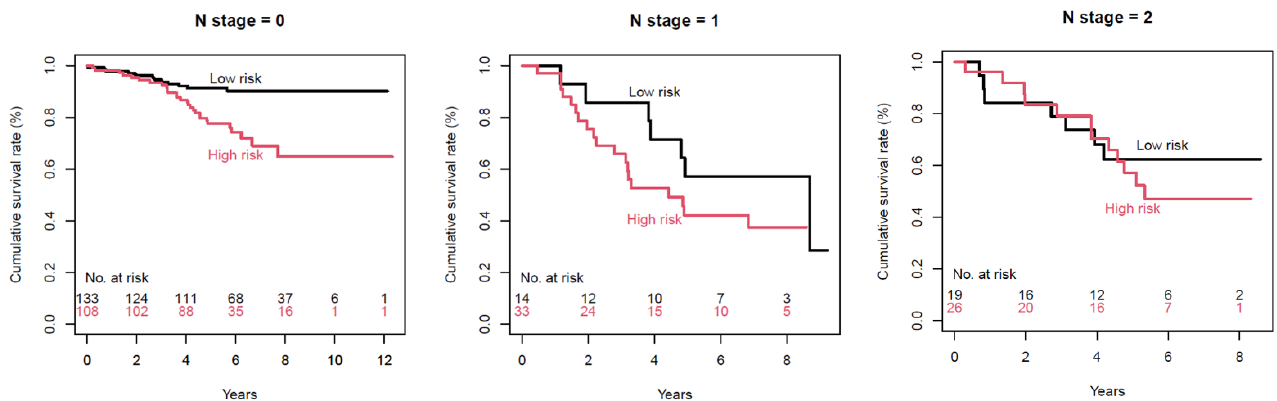
Figure 4. Kaplan–Meier survival curves per lymph node status, using radiomic margin characteristics. p -values were 0.0006, 0.2, and 0.6 for N0, N1, and N2, respectively.